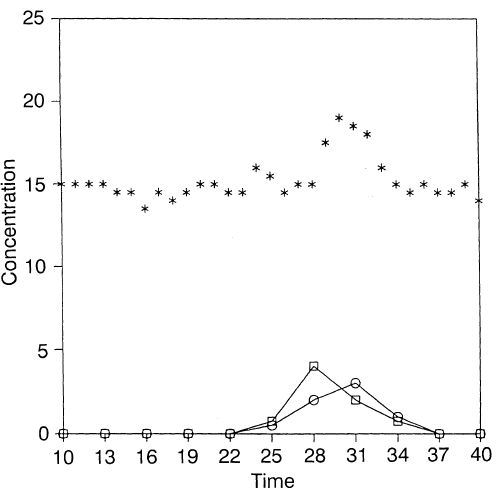
Fig. 12. Time evolution of pollutant concentration ( (cid:108) g m (cid:41) 3 ) measured ( stars ) and modeled ( squares -E1, circles -E2) at the